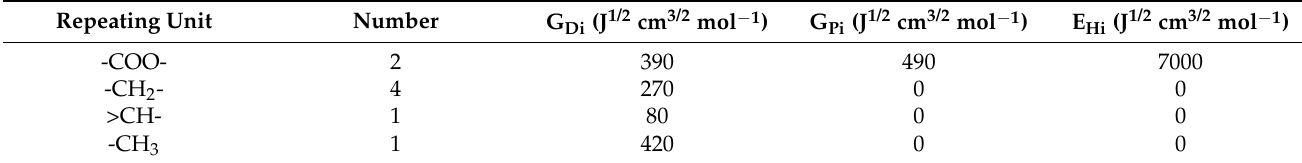
Table 1. G/E values of each repeating unit for